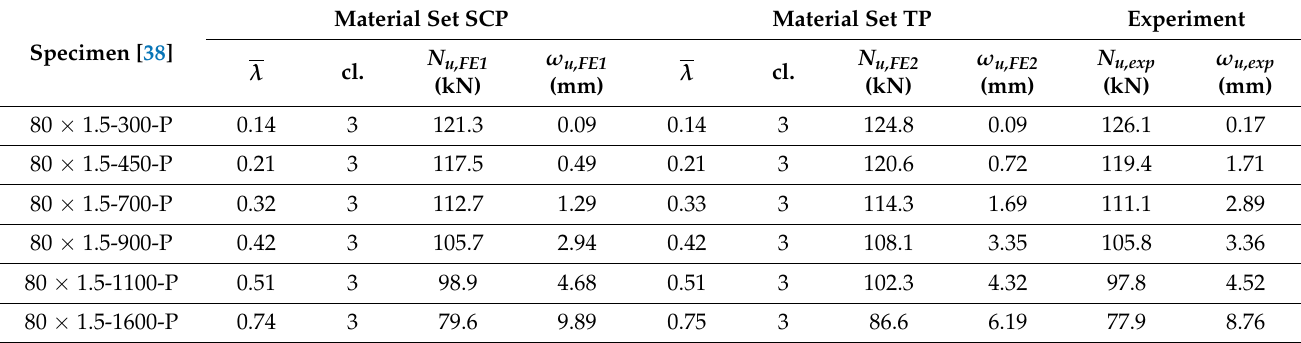
Table 11. Approach #A, FEA, and experiment results of the cross-section set 80 × 1.5 CHS pin-ended columns.